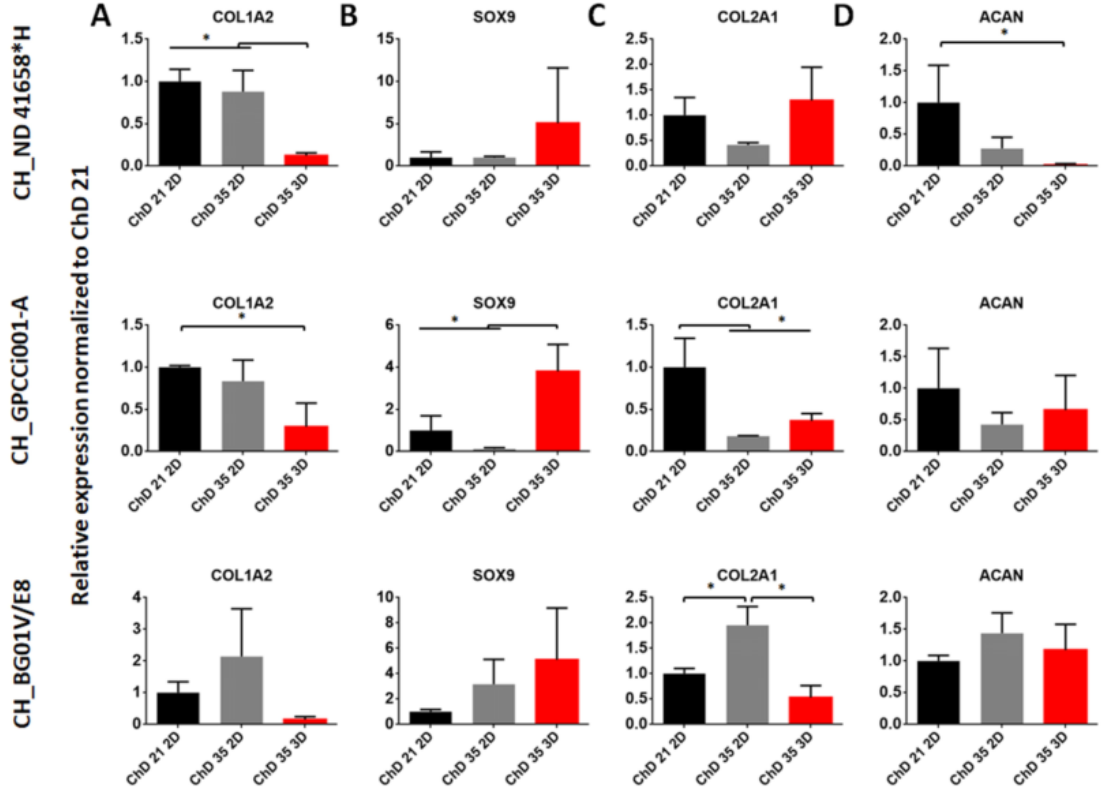
Figure 3. The e ff ect of prolonged and 3D culture on the expression of chondrogenic markers. RT-qPCR represents gene expression of markers specific to chondrogenesis during chondrogenic di ff erentiation ( A – D ). As a control, di ff erentiated PSC cells at ChD 21 2D were used. The error bars represent SD from three experiments. The statistical analysis was performed using ANOVA with Tukey’s post-hoc multicomparison test (* p < 0.05). ChD—Chondrogenic di ff erentiation; 2D—two-dimensional culture; 3D—three-dimensional